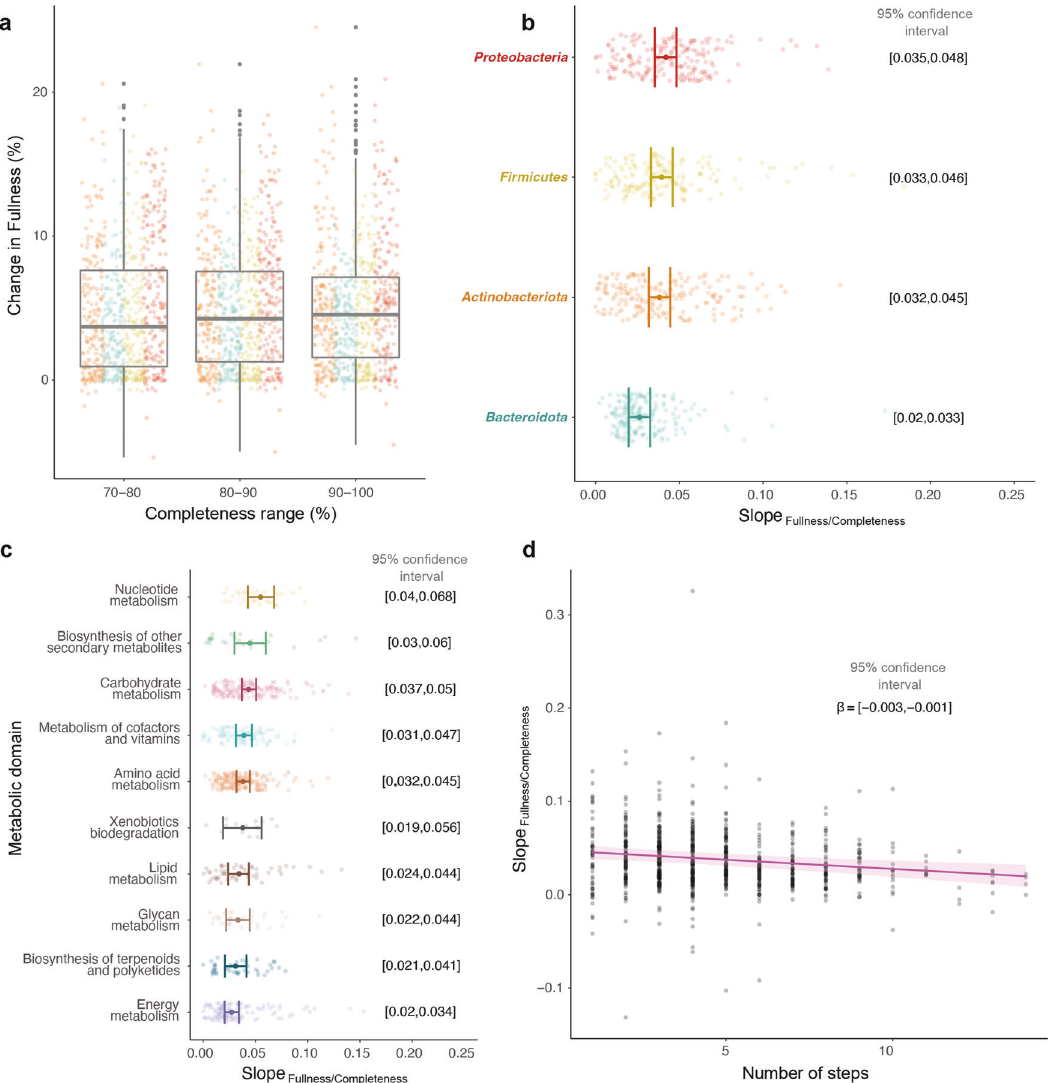
Fig. 2 Relationship between function fullness and MAG completeness. a Percentage of change in functional module fullness across different genome completeness windows with dots coloured by phylum. b Mean slope variation of the fullness/completeness relationship across bacterial phyla. c Mean slope variation of the fullness/completeness relationship across functional domains. d Relationship between the slope of the fullness/completeness relationship and the number of steps of the